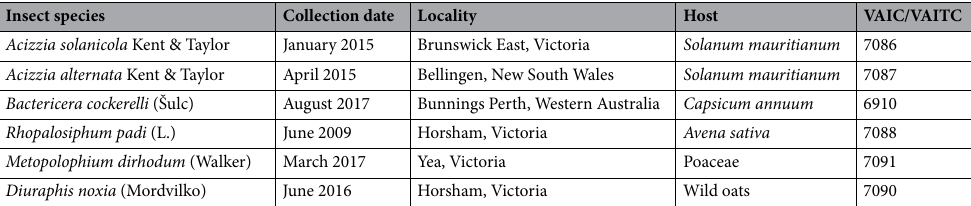
Table 1. Aphid and psyllid species used in the mock communities and associated collection details. VAIC Victorian Agricultural Insect Collection, VAITC Victorian Agricultural Insect Tissue